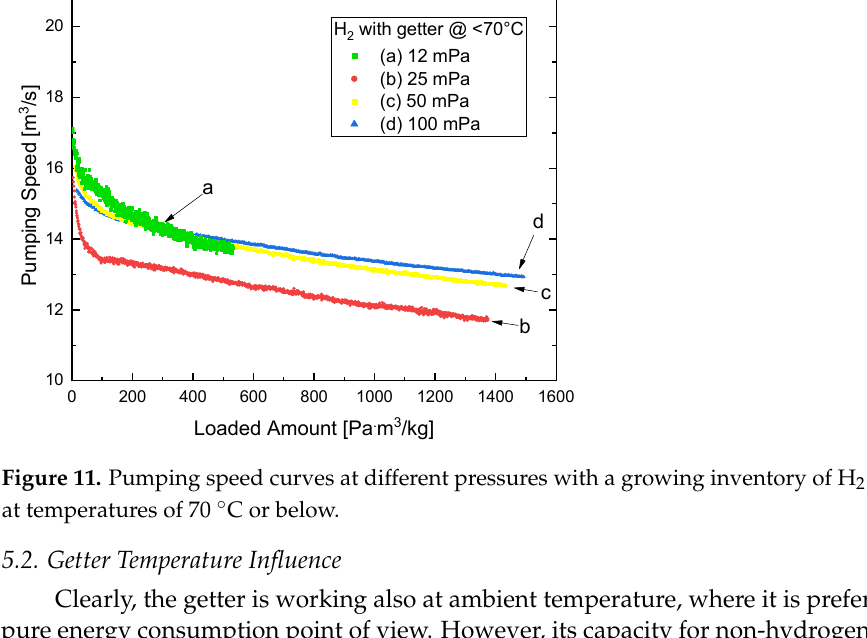
9 of 19 Figure 10. Pumping speed curves at different pressures with the growing inventory of H 2 with ZAO ® at 180 °C. Different pressures were established by different constant mass flows resulting in different durations to reach the same inventory. The effect of the decreasing pumping speed at higher pressures, caused by diffusion limitation from the getter surface into the bulk, becomes sig-